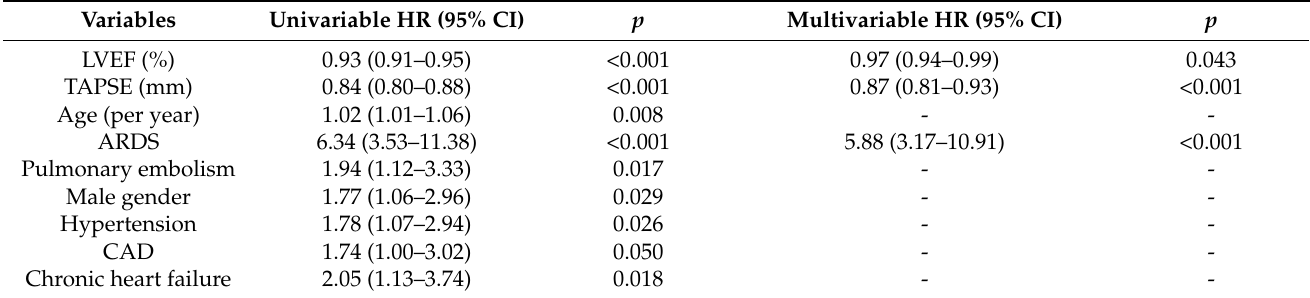
Table 3. Univariable and multivariable analysis for of the risk of 1-year